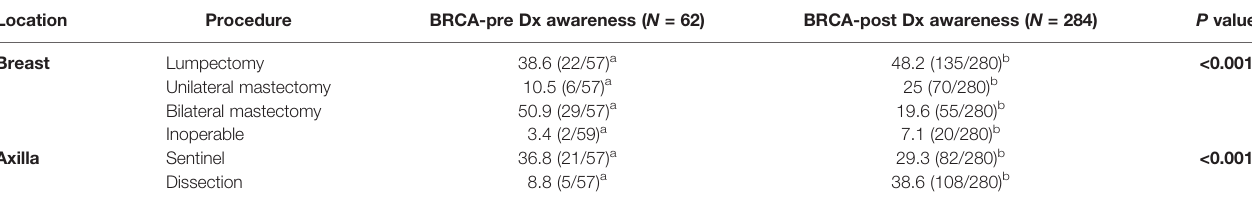
TABLE 3 | Therapeutic procedures among the study